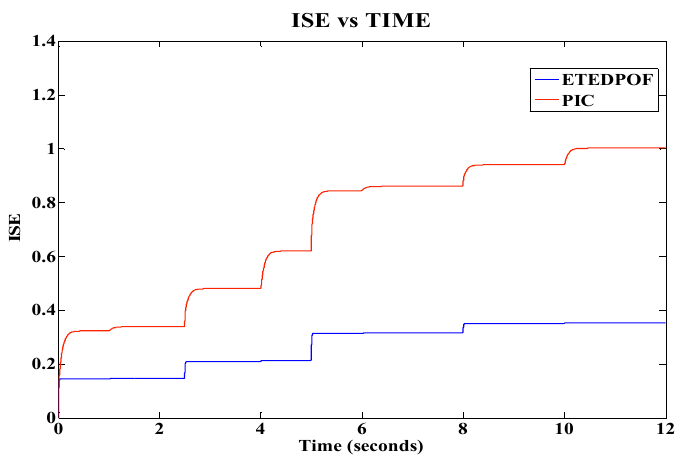
Figure 8. Integral Square Error (ISE) f or ETEDPOF and proportional-integral controller (PIC).